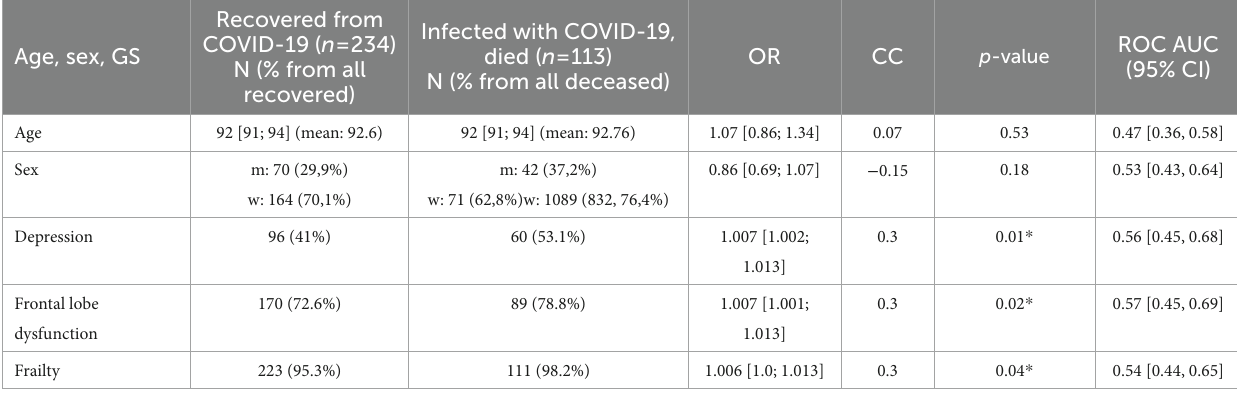
TABLE 5 GSs present in the participants who recovered or died from COVID-19 (with a significant difference in distribution), adjusted for age, sex, and multiple testing.